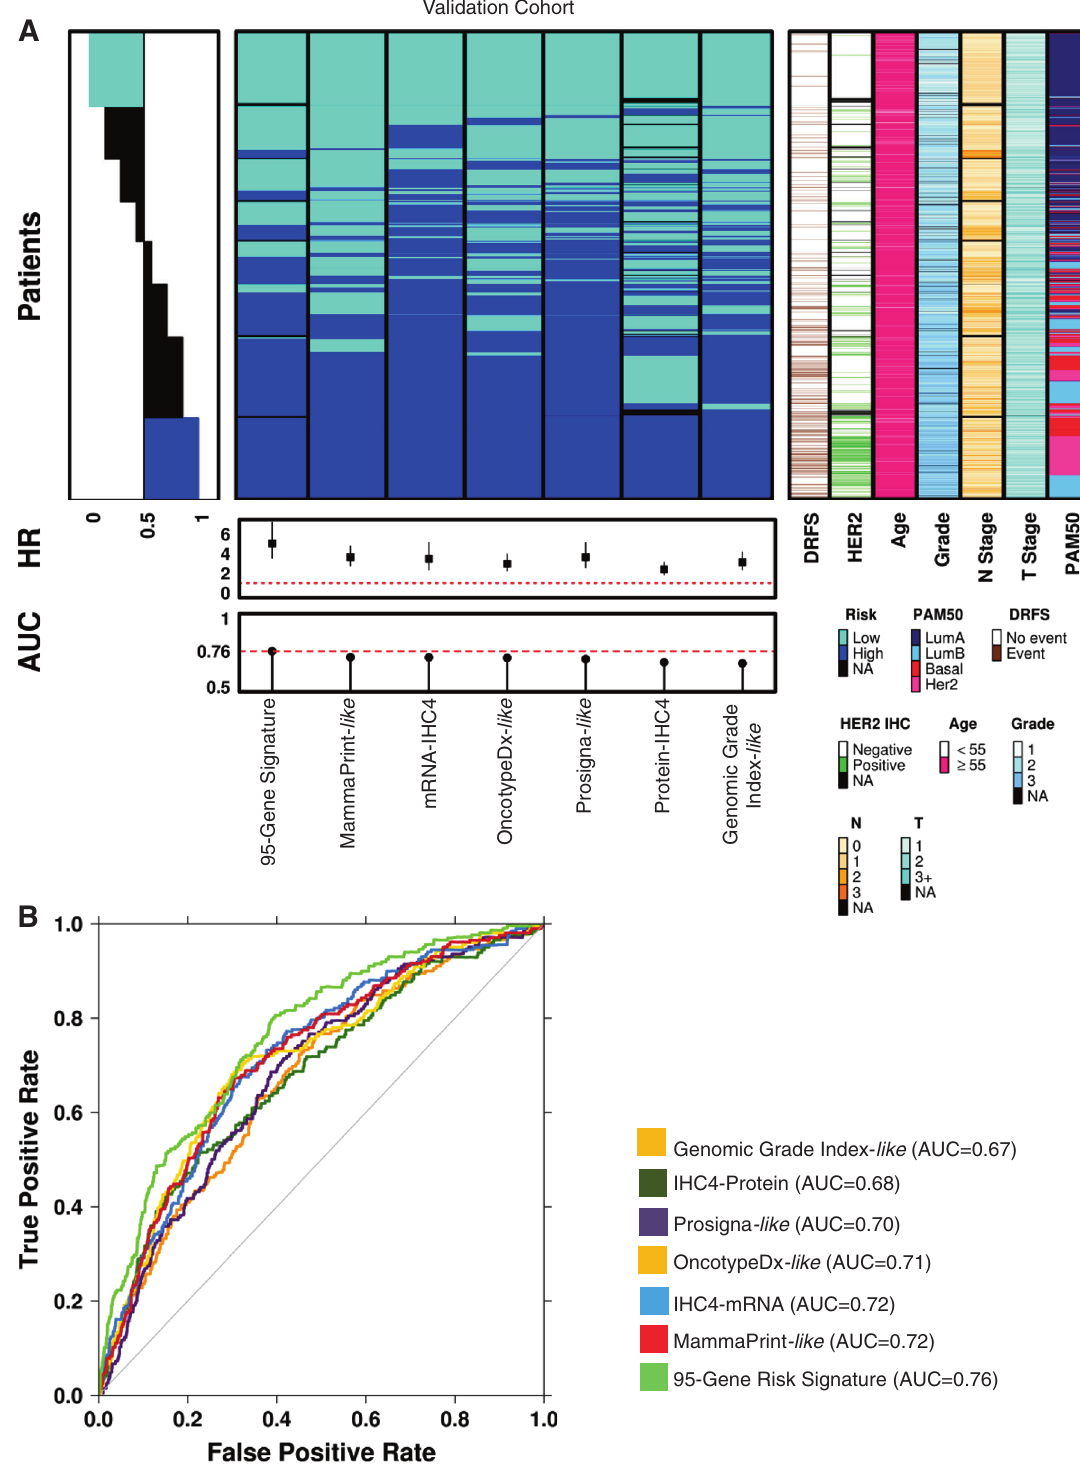
Fig. 2 Comparison of the 95-gene residual risk signature to multi-parametric tests in the validation cohort. a Summary of patients assessed in the validation cohort using the 95-gene residual risk signature and other current multiparametric tests in addition to clinical covariates. Patient samples were ranked according to overall concordance, with all patients called as high-riskor low-risk, across all tests organized at the bottom and top of the heatmap, respectively. Standard clinical covariates such as HER2 status, age, grade, nodal status, stage are included. Molecular subtyping based on the PAM50/Prosigna-like test is also shown. b As performance indicator, area under the receiver operating characteristic (AUC) curves for each multiparametric test is also shown. All patients represented are those who only received endocrine